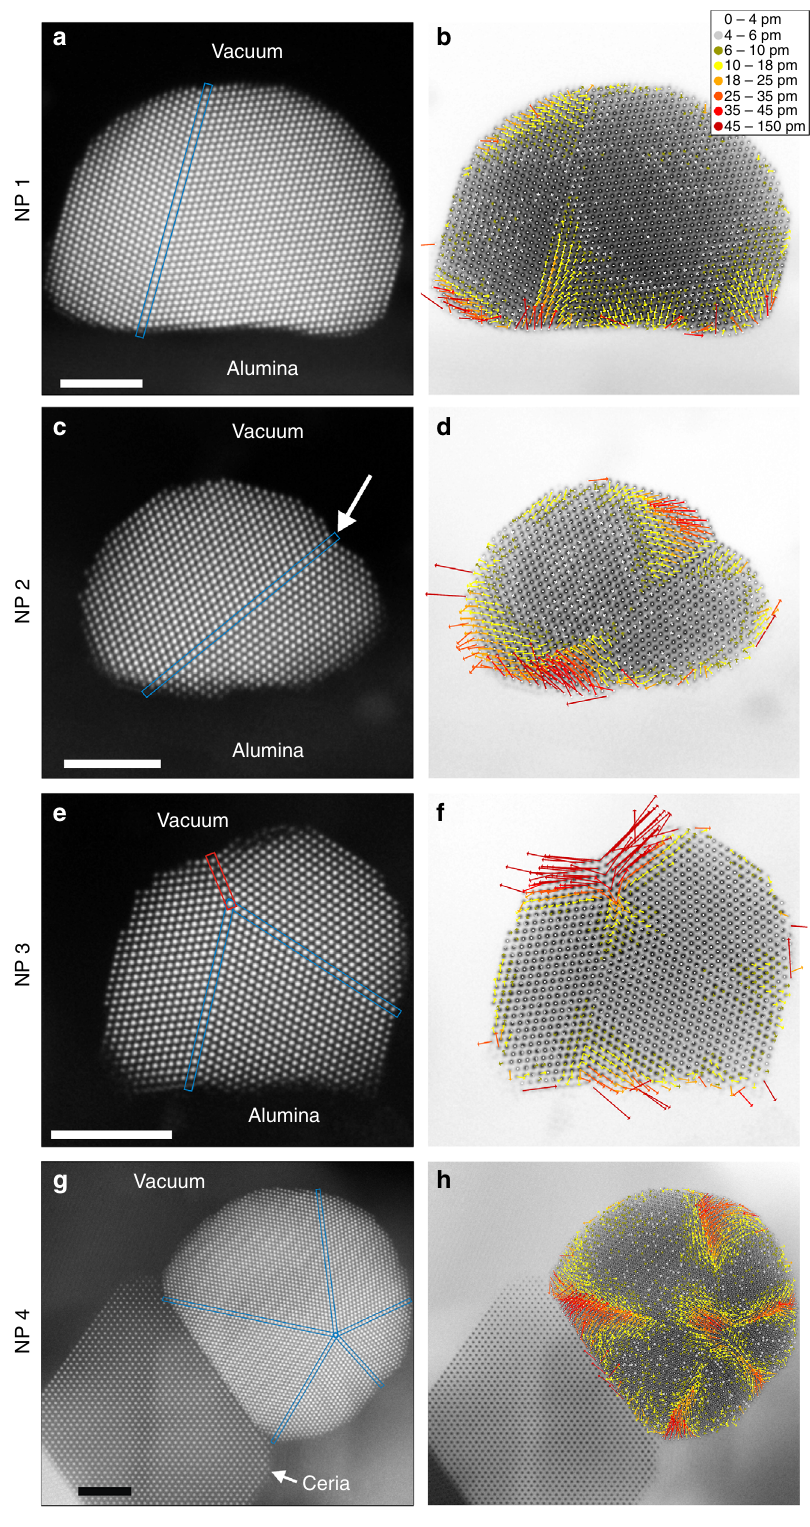
Fig. 1 High-precision atomic-resolution STEM images and displacement maps of supported Pt NPs. Left column, a , c , e and g : : High-precision side-view HAADF STEM images of Pt NPs along ‹ 110 › supported on alumina ( a , c , e ) and ceria ( g ). The interfaces between the NPs and the support are seen at the lower edge of the NPs. The arrow in c marks a concave re-entrant surface. Right column, b , d , f and h : Displacement maps showing the deviation of each atomic column position from their unstrained lattice positions. The arrows display the direction and magnitude of each displacement, as indicated in the legend. Each scale bar corresponds to 3 nm